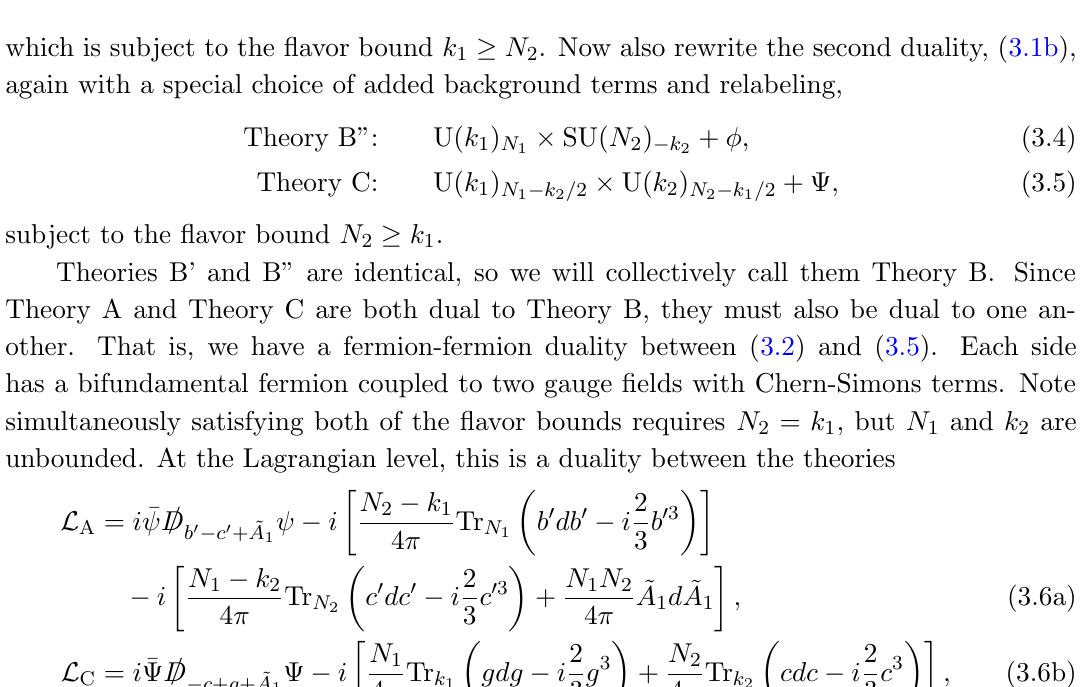
Figure 2 . Generalized fermion quiver duality of (3.6) with (cid:13)avor-bounded dualities. Theory B represents both Theories B’ and B" since they are identical. Our quiver notation is such that we use (cid:12)lled red (black) nodes to represent dynamical SU (U) gauge groups. The red (black) links between said circles represent fermions (scalars) charged under the corresponding gauge groups. This duality is subject to the (cid:13)avor bound N 2 = k 1